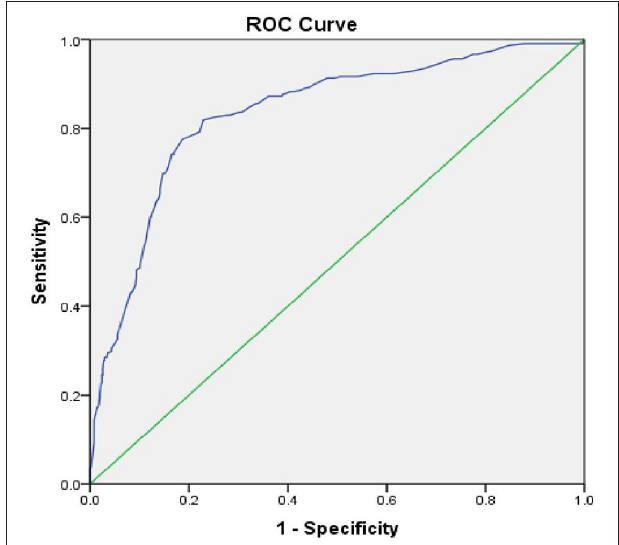
FIGURE 2 | ROC curve—random blood sugar values with cognitive impairment.